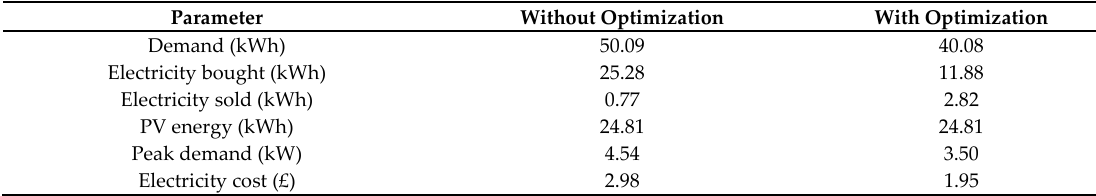
Figure 3. Daily demand and supplies ( a ) without optimization, and ( b ) with optimization. Table 1. Comparison between the main